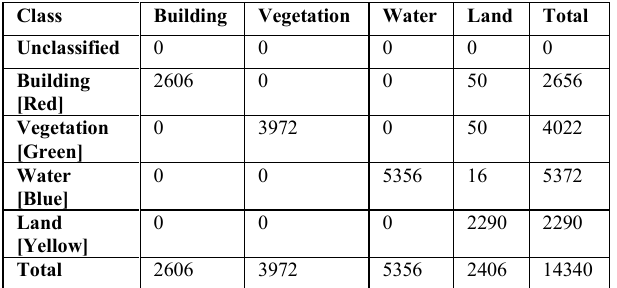
Table 2. Confusion Matrix Obtained Using